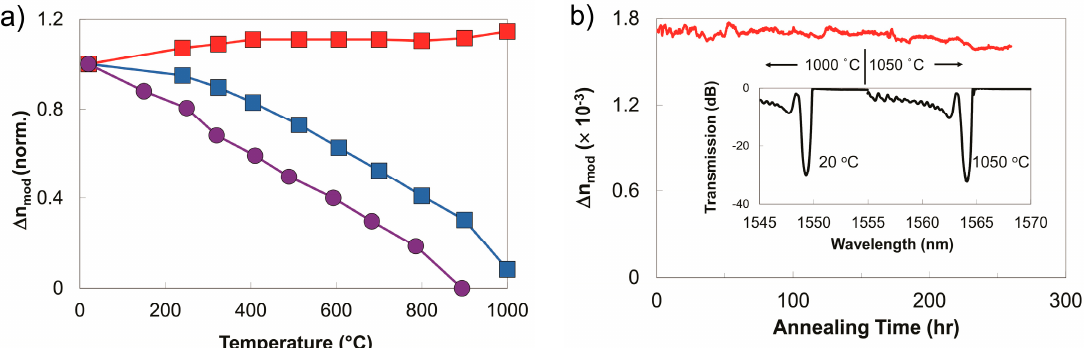
Figure 5. ( a ) Short-term annealing of Type II-IR (red), Type I-IR (blue) and Type I-UV (violet) grating held at each temperature for 1 h; ( b ) grating reflectivity expressed as its index modulation ( ∆ n mod ) for a thermally stable grating (red) as a function of time. (Inset) Grating spectrum as a function of